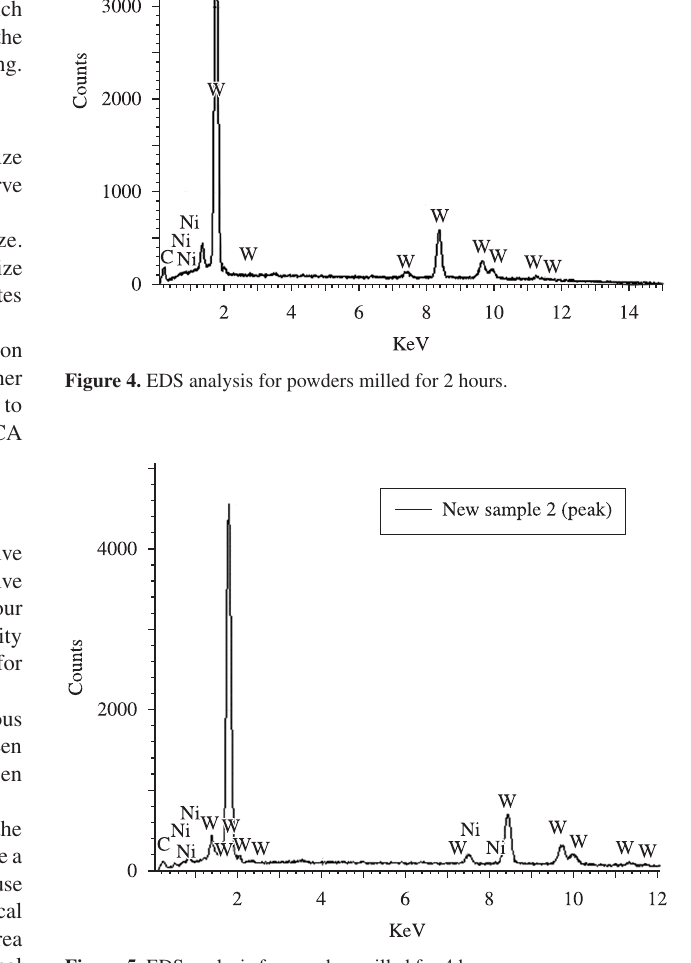
Figure 5. EDS analysis for powders milled for 4